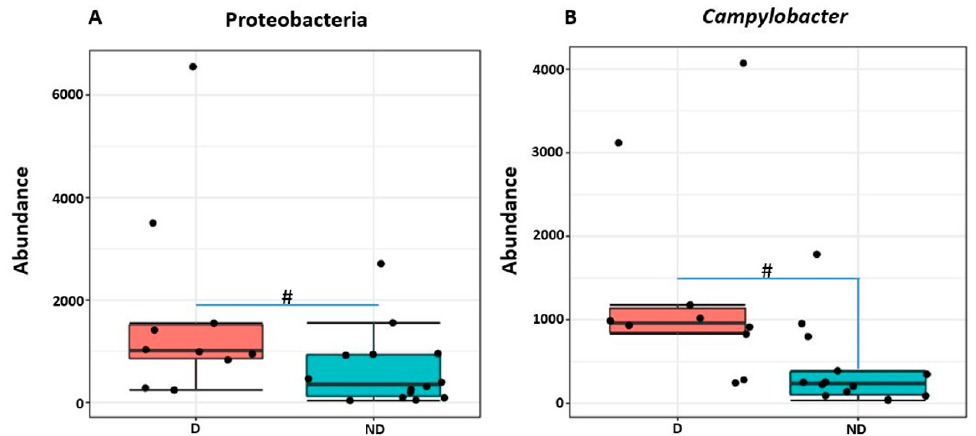
Figure 7. Abundance of Proteobacteria ( A ) and Campylobacter ( B ) in piglets with and without diarrhea. D and ND represent piglets with and without diarrhea, respectively. # represents significant difference between two groups at p < 0.05. Both Proteobacteria and Campylobacter were significantly increased in piglets with diarrhea as compared to healthy ones.